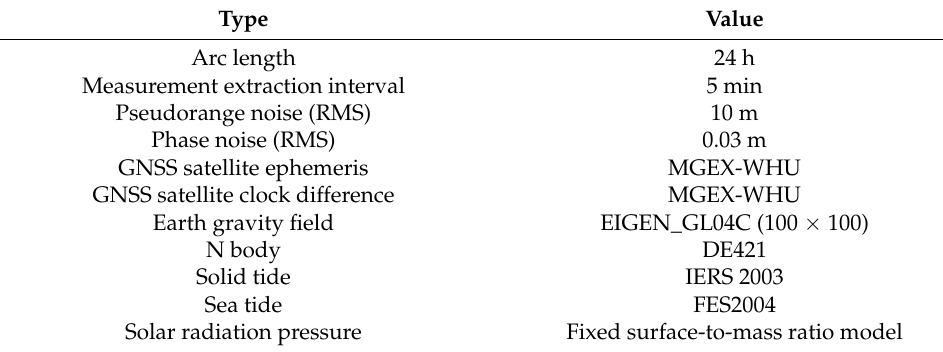
Table 3. GNSS observation data simulation strategy.